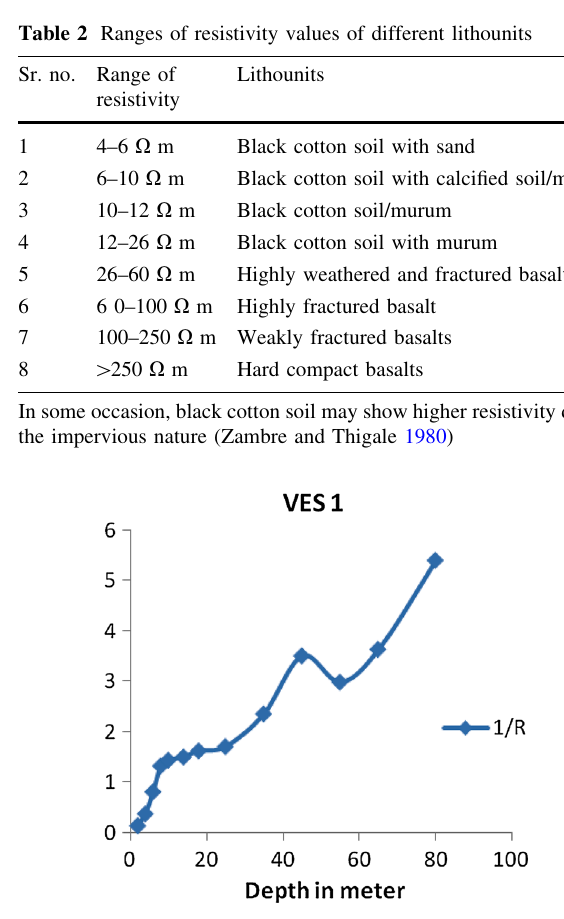
Fig. 4 Representative resistivity curve obtained by the inverse slope method from Sakri taluka